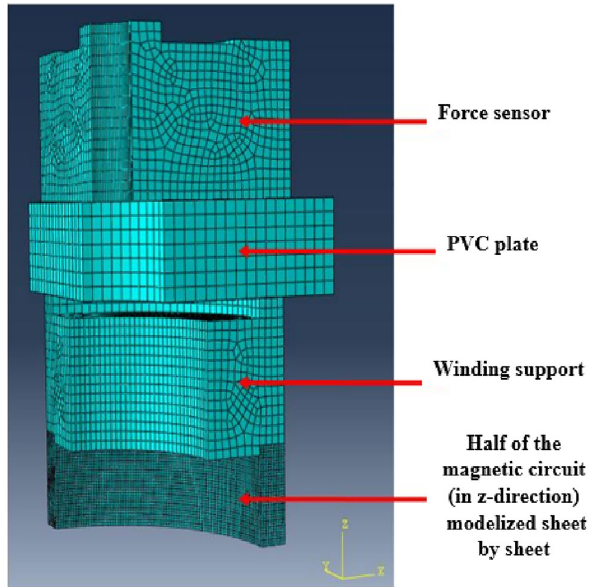
Figure 6. Mock-up modeled and meshed with Abaqus.